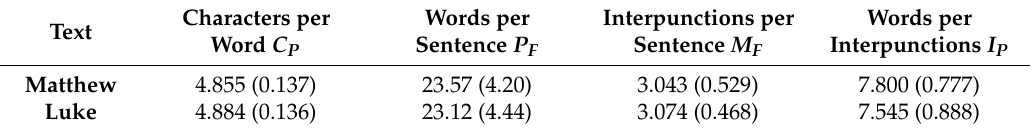
Table 7. Own Tradition. Average number of characters per word C P , words per sentence P F , interpunctions per sentence (also, number of word intervals) M F , words per interpunctions (word interval) I P . The numbers between parentheses give the standard deviations for text blocks of 500